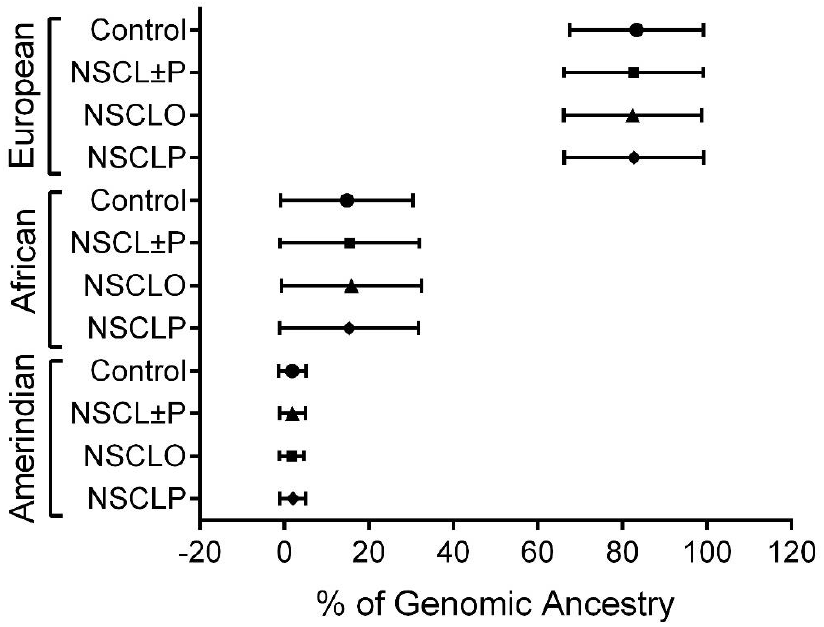
Figure 1. Genomic ancestry proportions from the groups of patients with nonsyndromic cleft lip with or without cleft palate (NSCL±P), nonsyndromic cleft lip only (NSCLO) and nonsyndromic cleft lip and palate (NSCLP) and control. Circle was designed to control group, square to NSCL±P, triangle to NSCLO and diamond to NSCLP. Table 1. Characteristics of single-nucleotide polymorphisms (SNPs), frequency of the minor alleles, Hardy-Weinberg equilibrium and genotyping call rates.